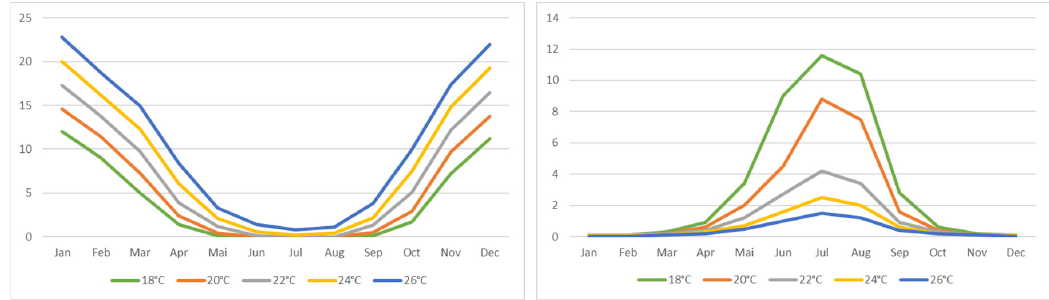
Figure 12. Sensitivity of set point temperature on monthly energy needs for heating ( left ) and cooling ( right ).